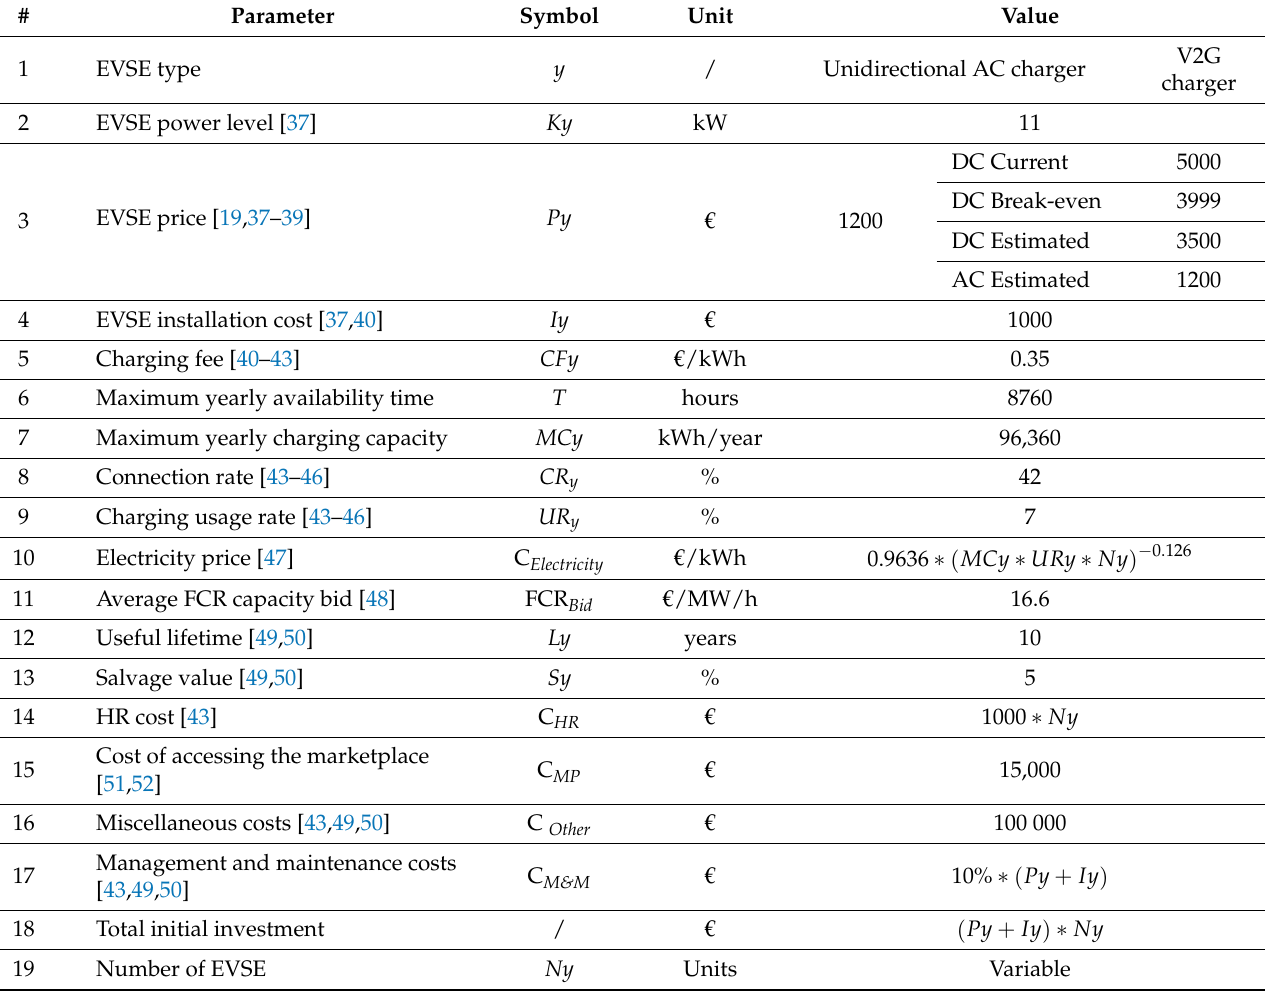
Table 3. Values of the factors participating into the profitability evaluation of the business